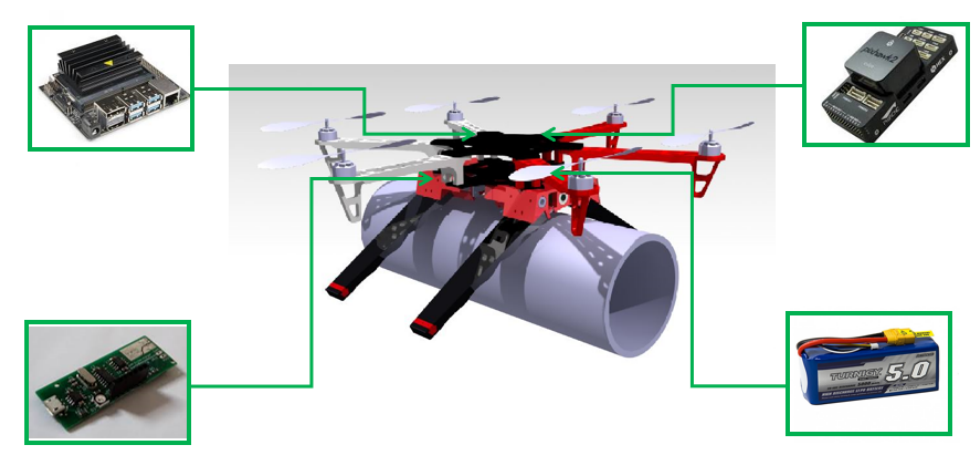
Figure 15. Setup including in the flying